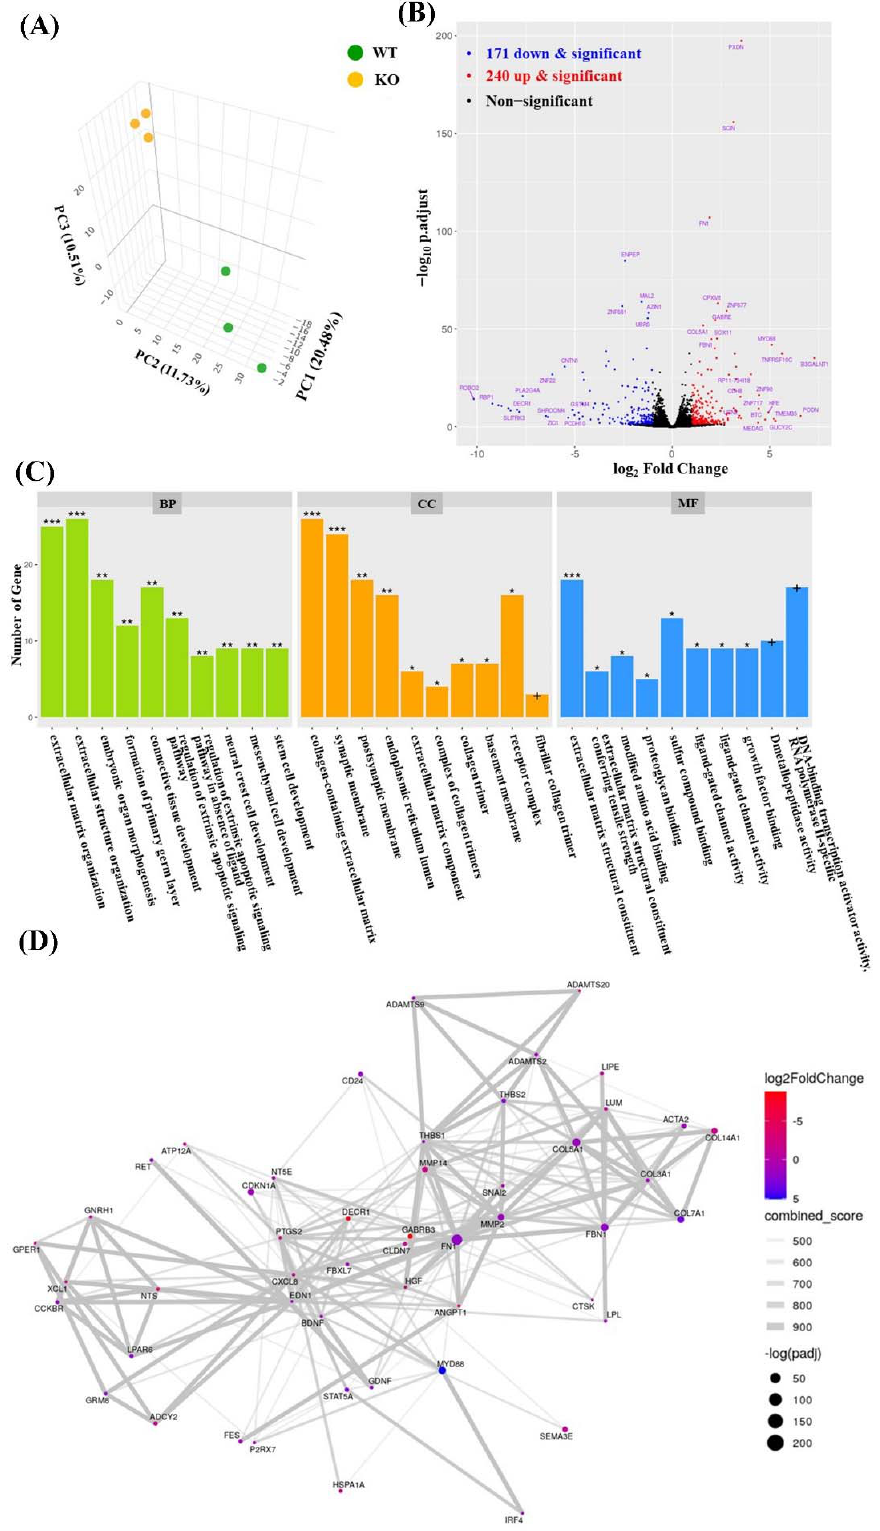
Figure 2. Analysis of RNA sequencing data: ( A ) three-dimensional principal component analysis plot; ( B ) volcano plot showing the DEGs between ARC ‐ KO cells and ARC ‐ WT cells; ( C ) GO terms associated with the DEGs in the biological process (BP), cell component (CC), and molecular function (MF) ontologies. Adjusted p ‐ value, + < 0.1; * < 0.05; ** < 0.01; *** < 0.001; ( D ) protein–protein interaction network constructed using the top 50 DEGs.